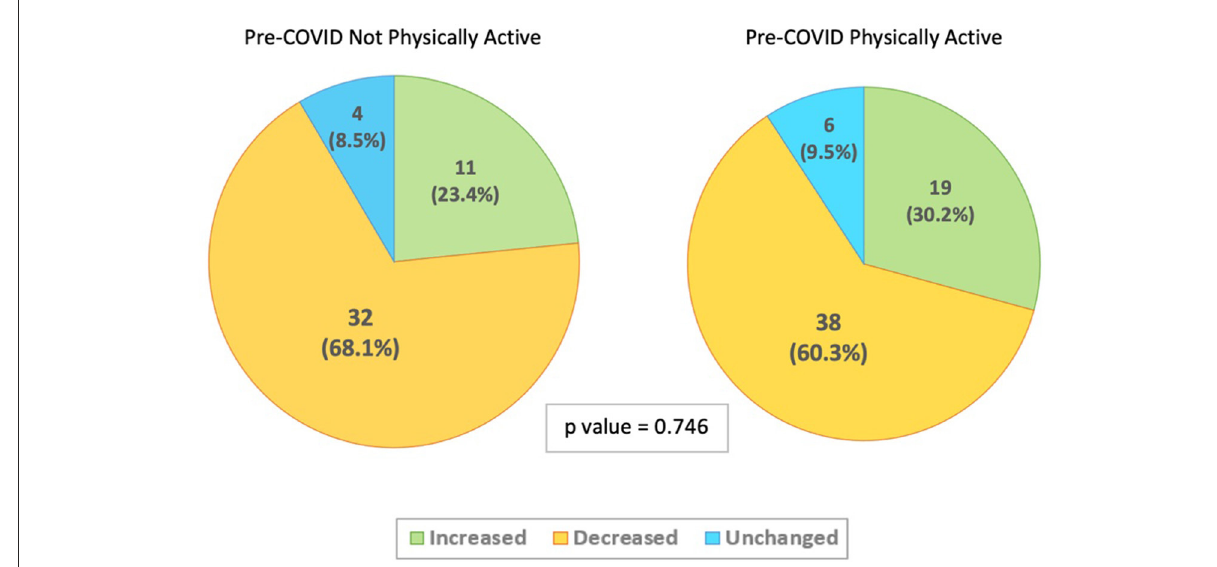
FIGURE1 Change in physical activity levels during COVID-19 social distancing measures stratified by Pre-COVID-19 physical activity levels ( N = 110).